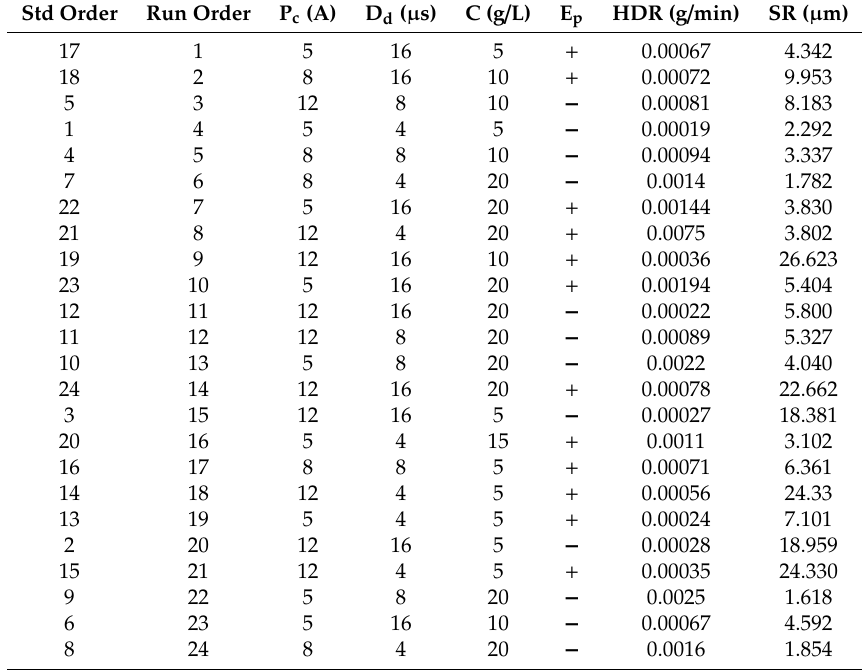
Table 2. Design of experiment (DOE) matrix and Experimental results for the HDR.